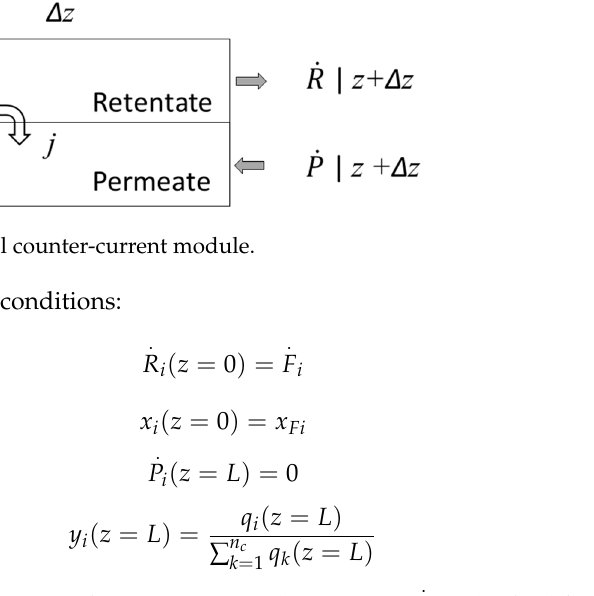
Table 1. Nomenclature for planar and circular fiber bundle domain geometry.